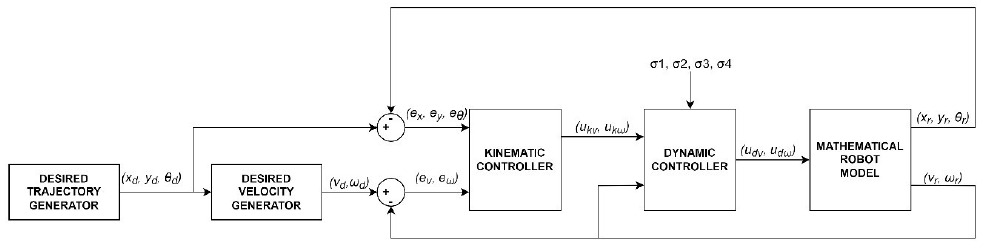
Figure 6. Block diagram of the tracking motion simulation of the TURTLEBOT 2